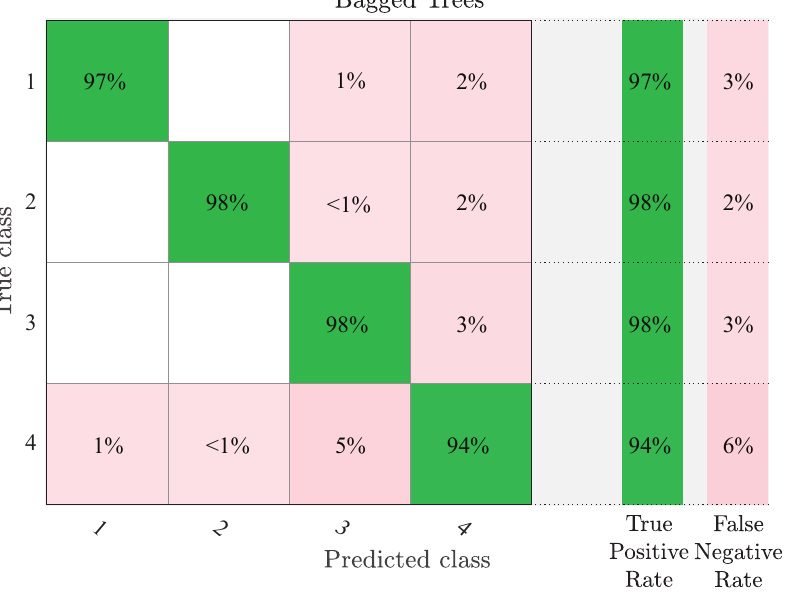
Figure 17. Confusion matrix of